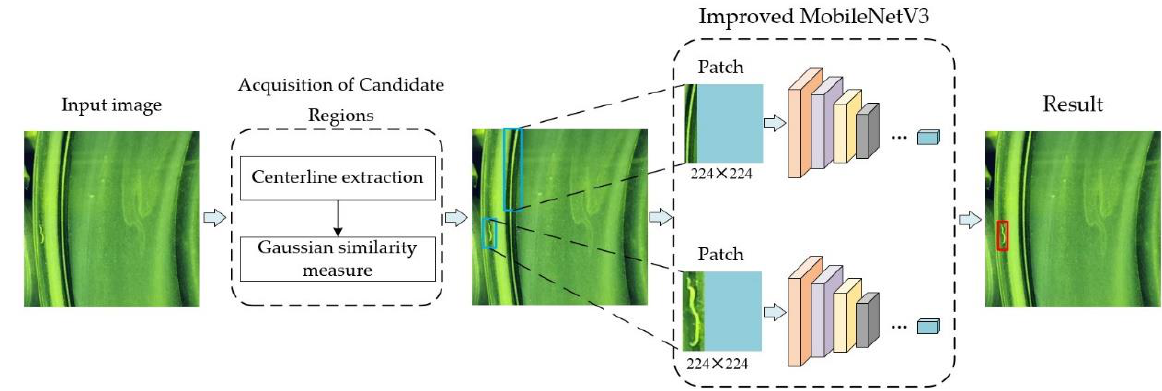
Figure 2. Overview of the bearing ring defect identification method.